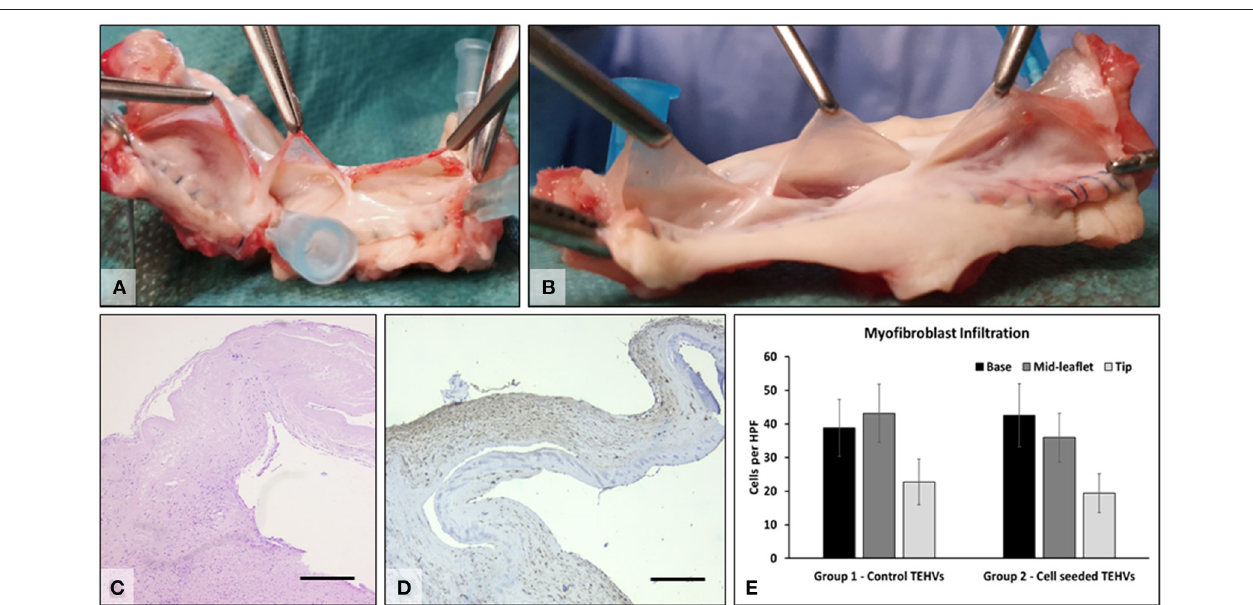
FIGURE 6 | Explant analysis. (A) Representative macroscopic images of freshly explanted TEHV and (B) cell-seeded TEHV. (C) Representative H&E stain of cells found within the valve interstitium; (D) immunohistochemistry for alpha-smooth muscle actin (brown, positive). Bar is 200 µ m. (E) Quantitative data on alpha-smooth muscle actin positive cells infiltrated in the base, middle, and tip areas of the TEHVs. Statistical analysis revealed no significant differences in the number of infiltrated cells between the two valve